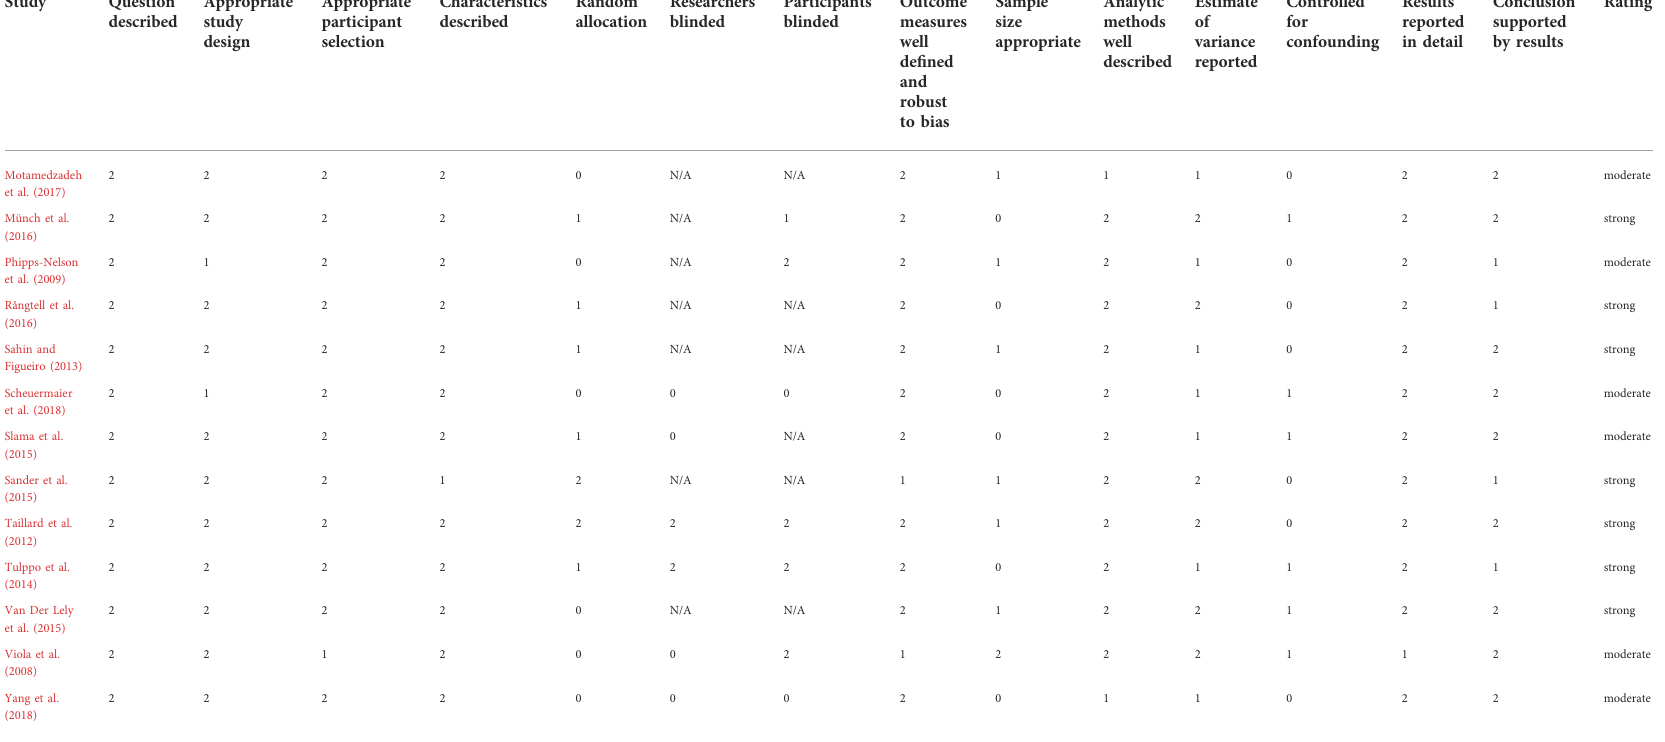
Viola et al. (2008) Yang et al. (2018) N/A not applicable, 2 indicates yes, 1 indicates partial, 0 indicates no; Quality scores: > 75% strong, 55% ≥ 75% moderate, < 55%